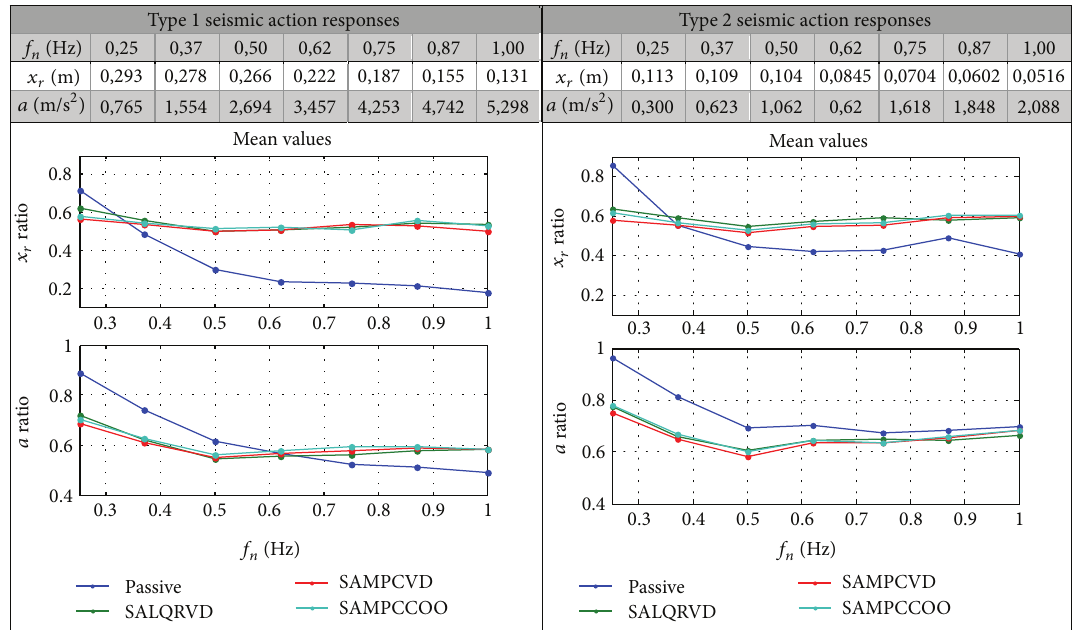
Figure 9: SDOF mean peak response values for the original system and ratios (relative to the original structure) for different system’s natural frequencies.